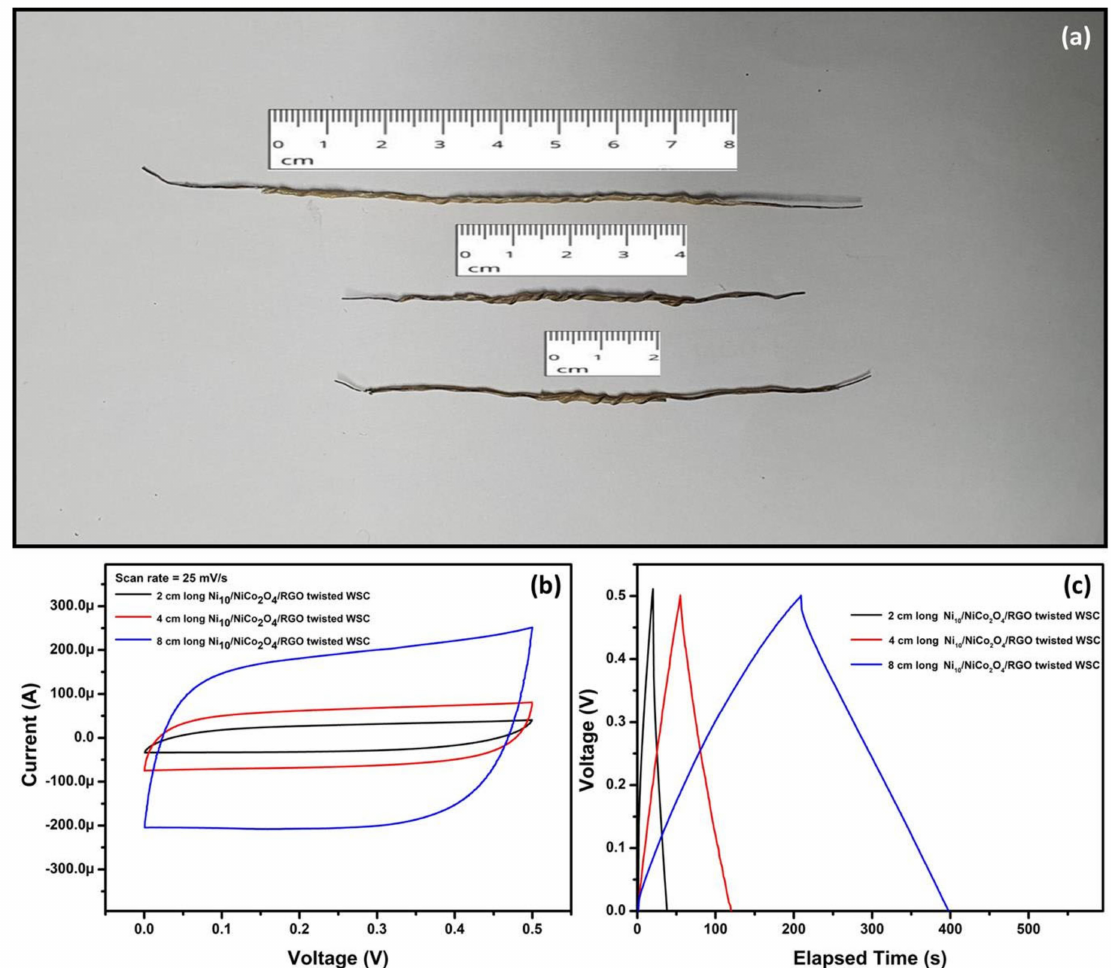
Figure 15. ( a ) Photograph of the fabricated Ni 10 /NCO/RGO WSCs with various lengths, ( b ) CV curves for various length Ni 10 /NCO/RGO WSCs at 25 mV/s scan rate under 0–0.5 V potential window, and ( c ) GCD curves obtained at applied currents of 25 µ A for various length Ni 10 /NCO/RGO